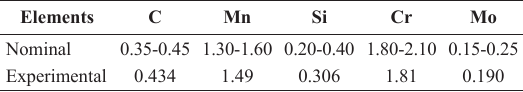
Table 1- Chemical composition (wt %) and nominal chemical composition of W. Nr. 12.311 (AISI P20) [8] .